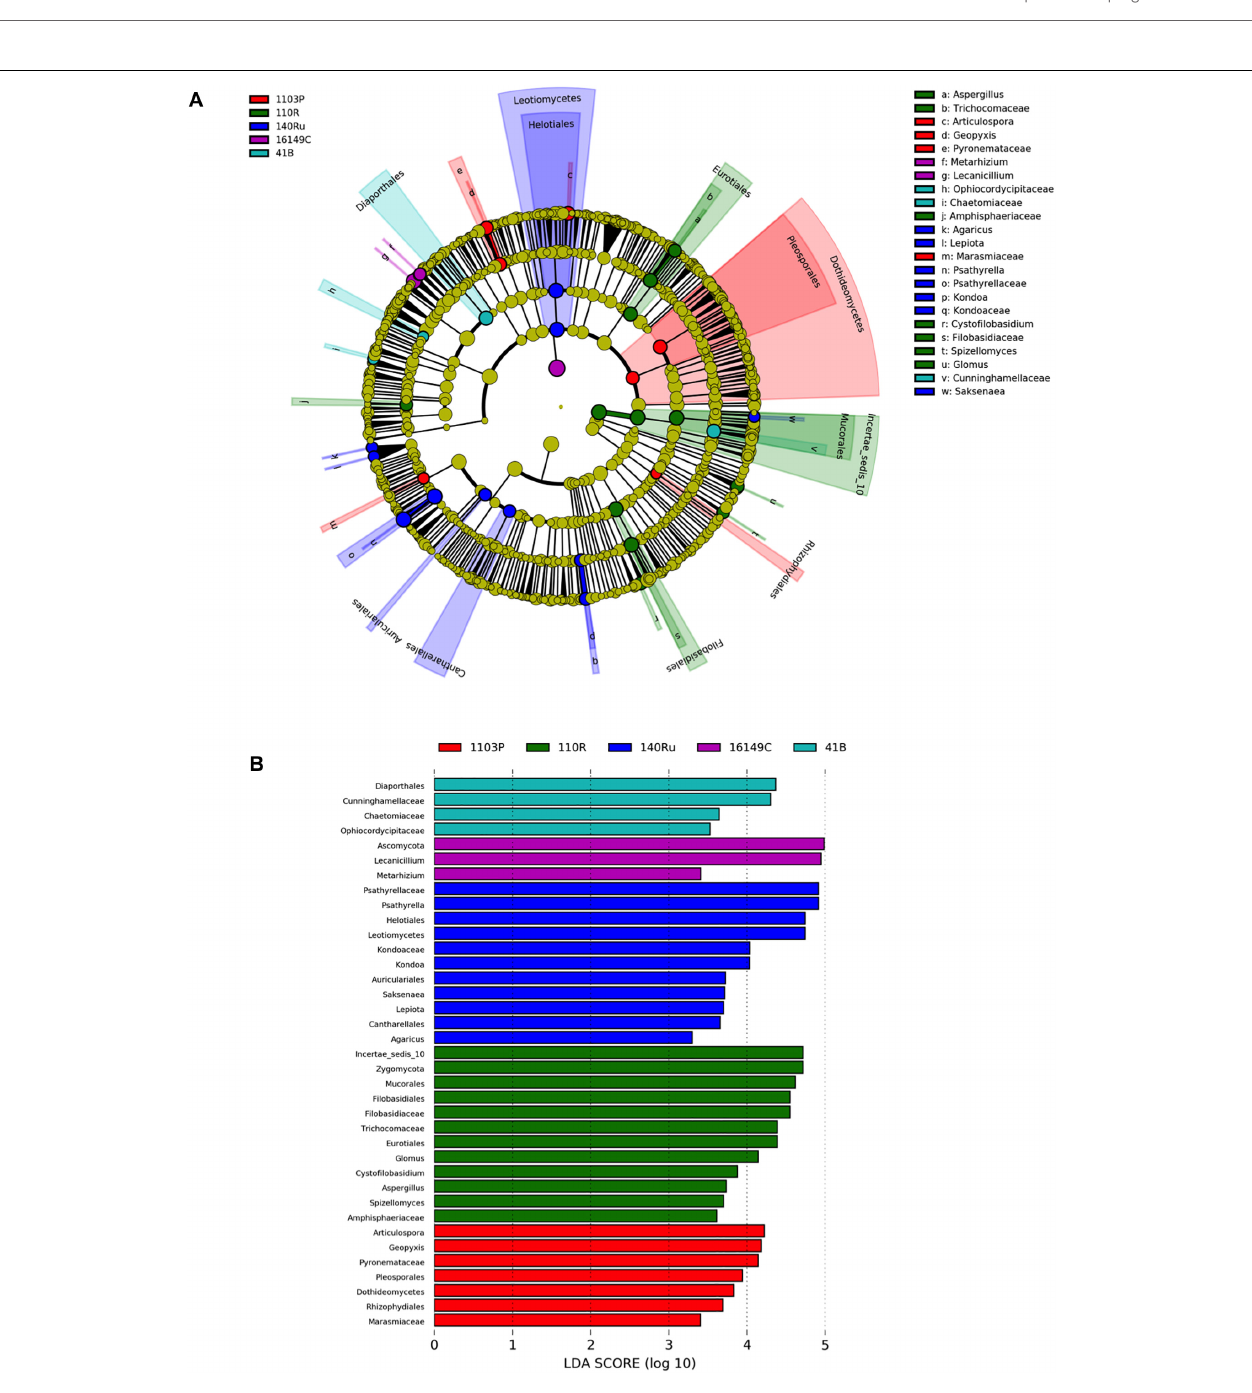
FIGURE 4 | LEfSe was used to identify the most differentially abundant taxa among grapevine rootstocks in Aldea vineyard. Cladogram generated by LEfSe indicating differences of fungi (A) at phylum, class, family, and genus levels between the five groups (relative abundance ≤ 0.5%). Each successive circle represents a phylogenetic level. Color regions indicate taxa enriched in the different rootstocks. Differing taxa are listed on the right side of the cladogram. Bar graph showing LDA scores for fungi (B) . Only taxa meeting an LDA significant threshold > 2 are